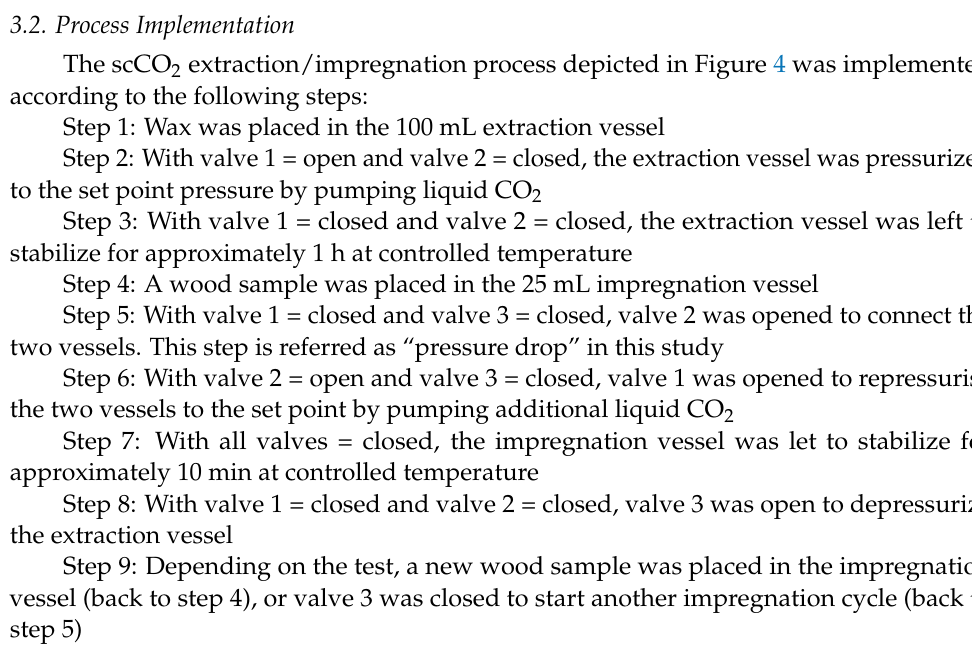
Figure 6. Picture of wood sample as it is removed from the impregnation vessel.